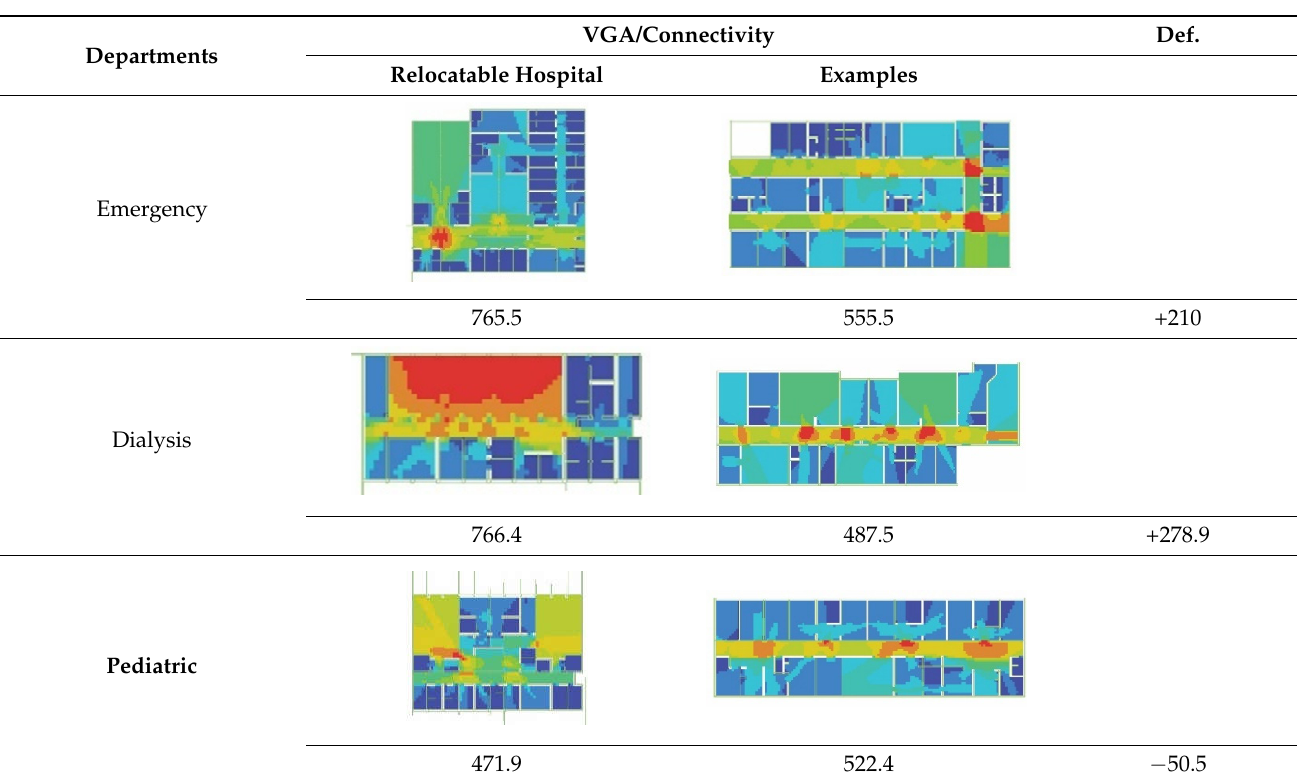
diology, and endoscopy departments. A well-connected plan represented a good rela- tionship between patient and staff spaces, strengthening the accessibility. Table 14. Visual graph analysis/connectivity values and graphs of case study departments com- Table 14. Visual graph analysis/connectivity values and graphs of case study departments com- Table 14. Visual graph analysis/connectivity values and graphs of case study departments com- Table 14. Visual graph analysis/connectivity values and graphs of case study departments com- pared to examples. Table 14. Visual graph analysis/connectivity values and graphs of case study departments com- Table 14. Visual graph analysis/connectivity values and graphs of case study departments com- pared to pared to examples. pared to examples. Table 14. Visual graph analysis/connectivity values and graphs of case study departments compared pared to examples. pared to examples. to examples.